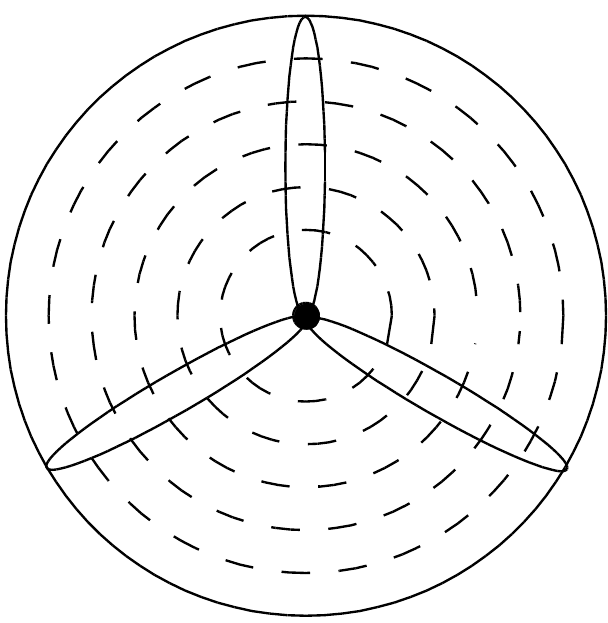
Figure 1. Annular rings on a turbine